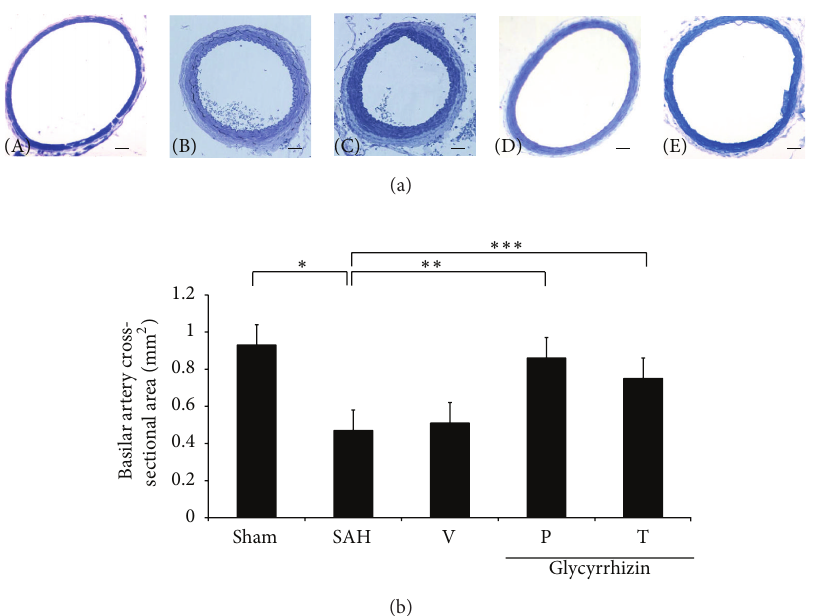
Figure 1: Comparison of lumen cross-sectional areas of the basilar artery. (a): representative micrographs of the cross-section of basilar artery obtained from the sham operated rat (A), the vehicle-treated SAH rat (B), SAH rat precondition treated with glycyrrhizin (C), and glycyrrhizin pretreatment in SAH animals (D), and SAH rat received glycyrrhizin after the induction of hemorrhage (E). Standard bar = 200 𝜇 m (b): quantification of the lumen cross-sectional areas. All values are mean ± SD ( 𝑛 = 9 ). Glycyrrhizin exerted a potential to alleviate the vasospastic response when compared with the vehicle +SAH group. ∗ , ∗∗ , ∗∗∗ : 𝑃 < 0.01 compared with the SAH